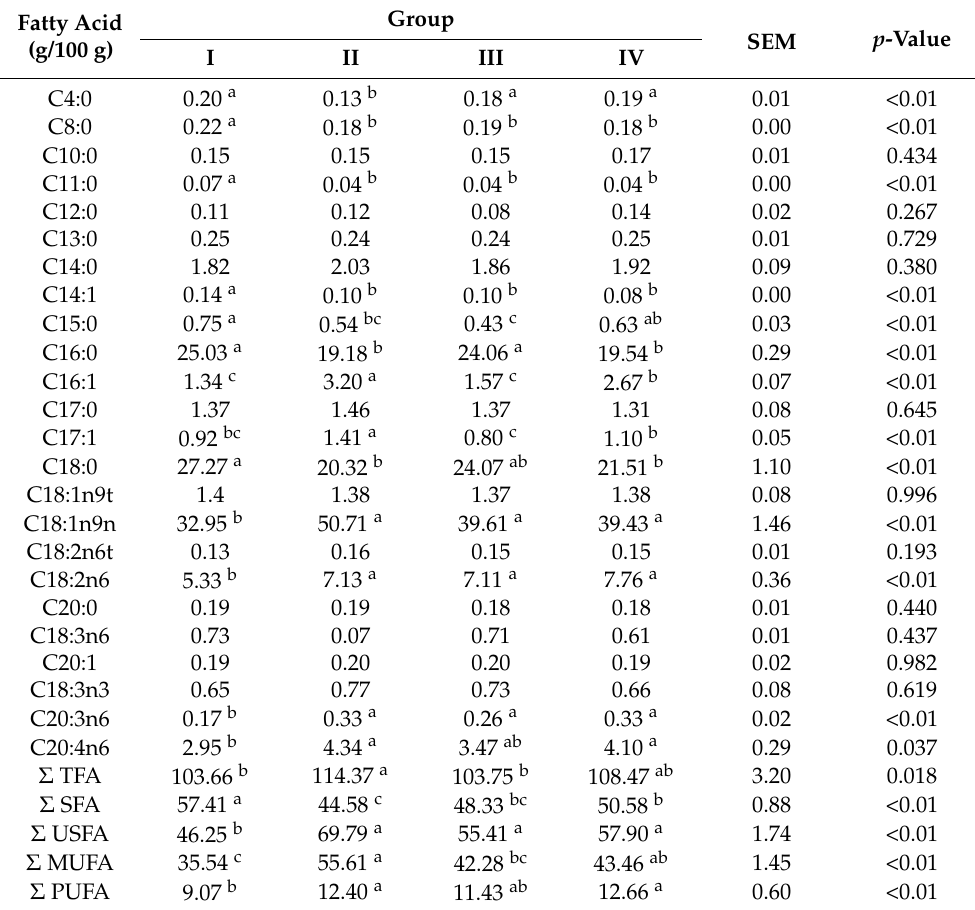
Table 7. Effect of different processing modes of mulberry leaf TMR diet on black goat muscle fatty